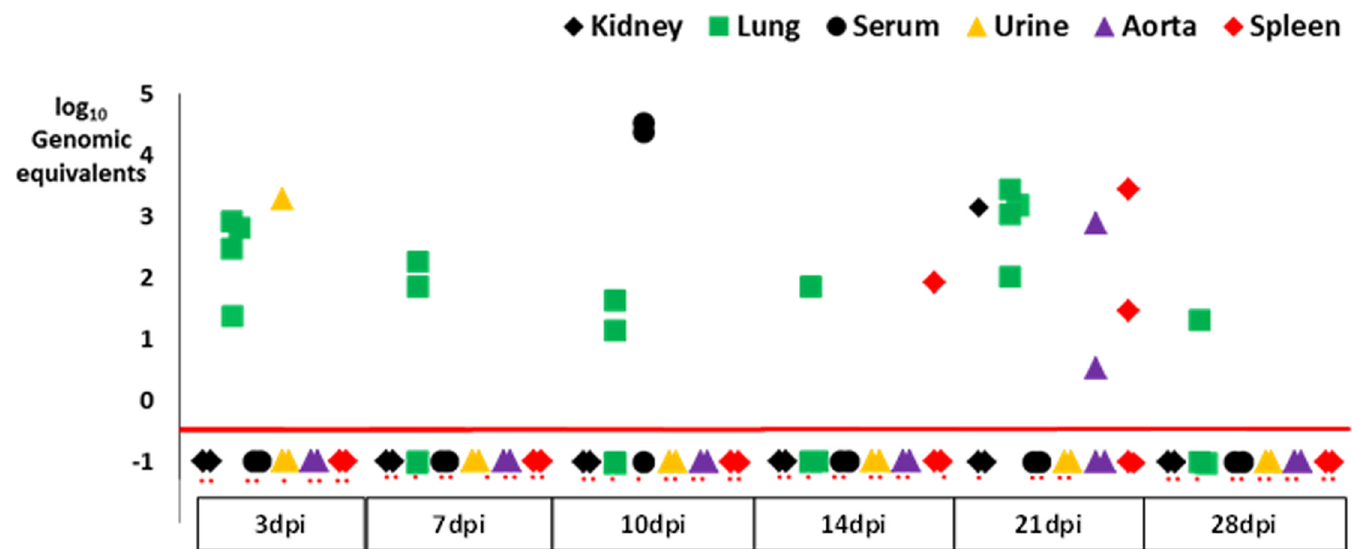
Fig 2. Dot plot of organ-specific viral loads in mice infected by the intragastric route expressed as log 10 viral genomic equivalents/mg wet weight for solid organs and copies/mL for body fluids. Samples plotted below the horizontal red line had no detectable viral DNA. On the X-axis, red dots beneath the square, diamond, circle, and triangle organ symbols represent 2 mice each. Heart, stool, colon are not shown because all of these samples tested